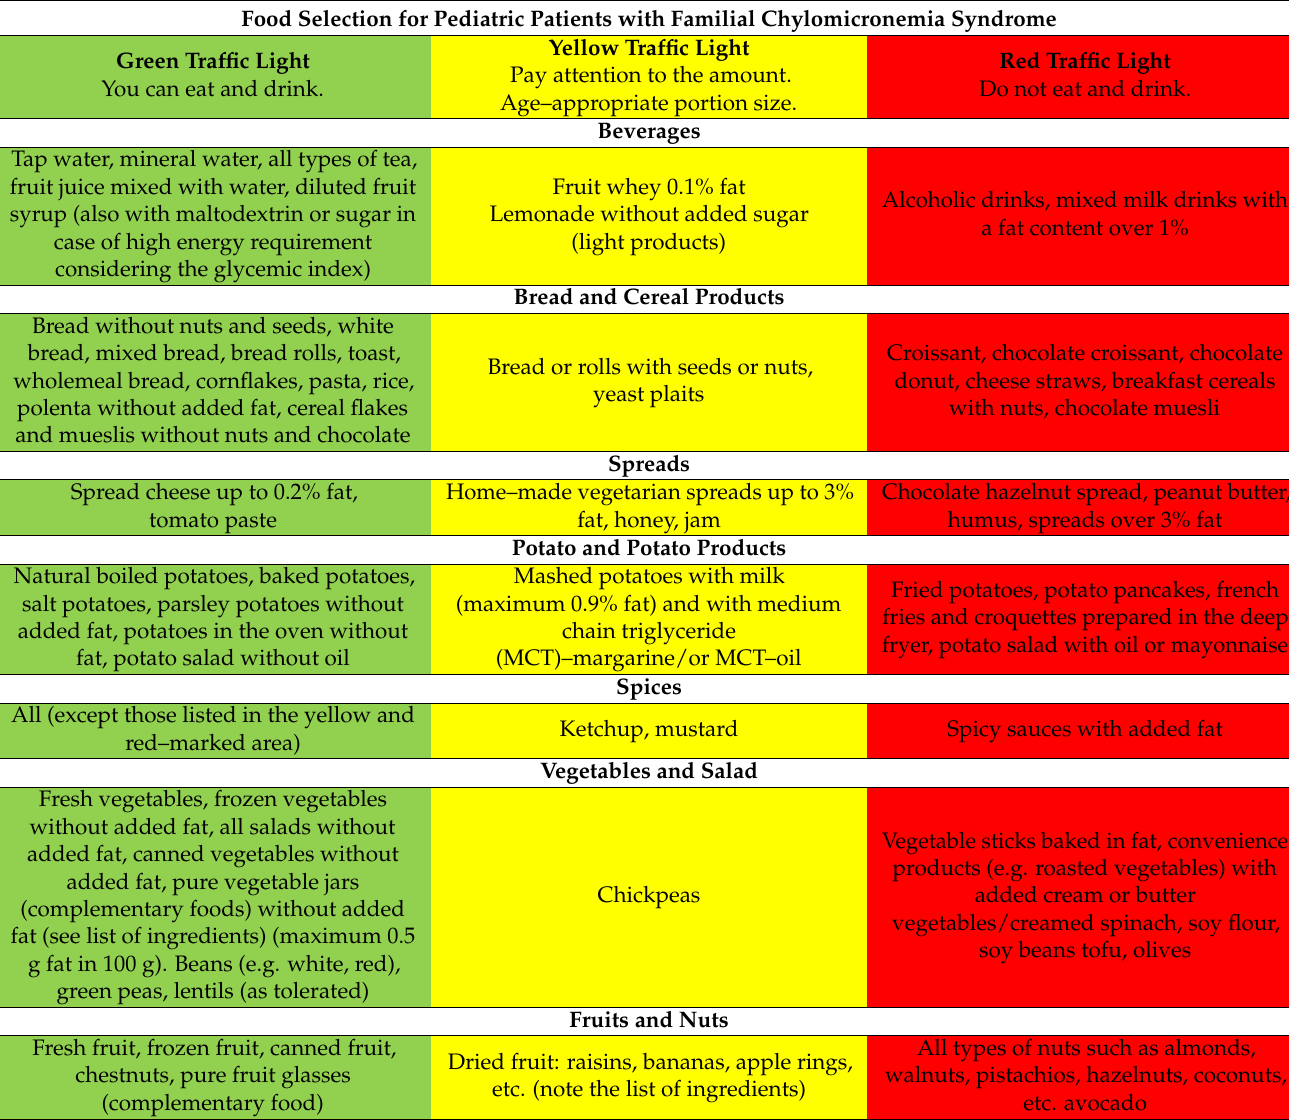
Table 1. Familial chylomicronemia syndrome traffic light